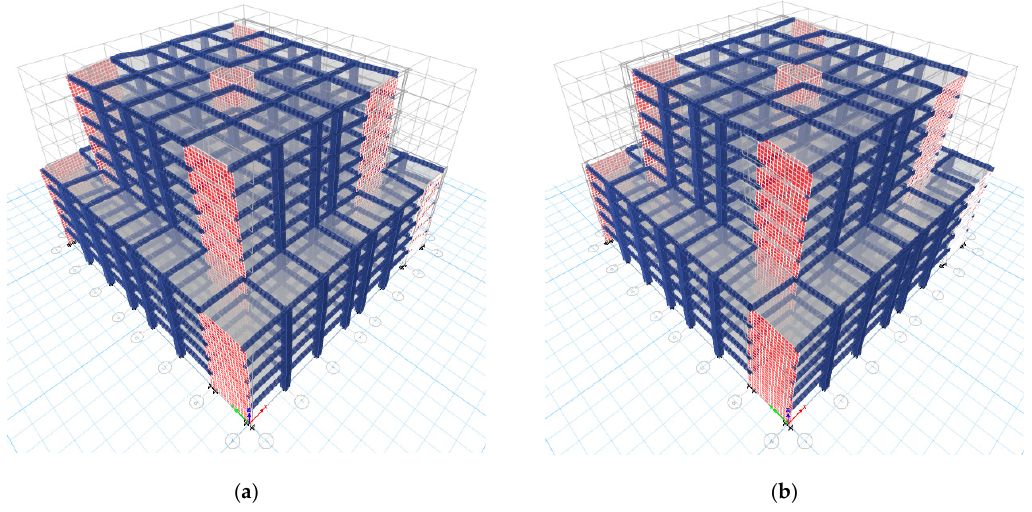
Figure 19. First two modes: ( a ) the 1st mode, and ( b ) the 2nd mode.